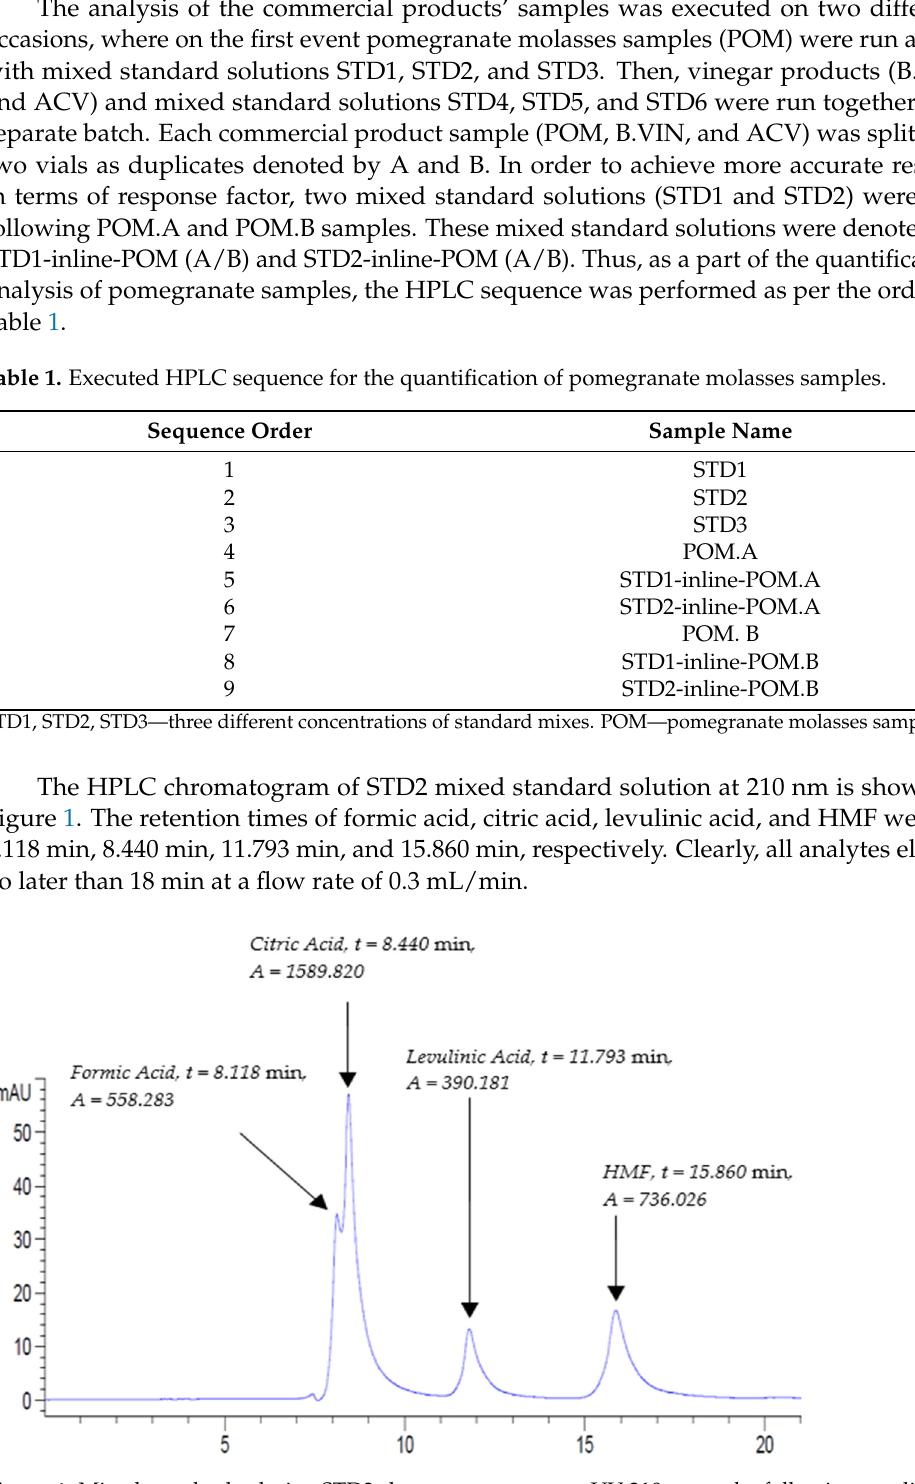
Figure 1. Mixed standard solution STD2 chromatogram run at UV-210 nm at the following condi- tions: flow rate, 0.3 mL/min; column temperature, 30 °C; and run time, 20